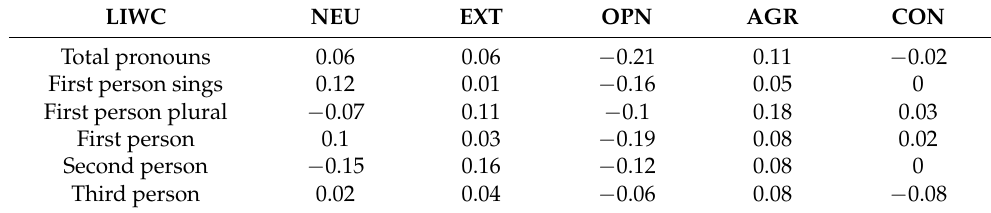
Figure 6. Analysis of relevant sentiments of predominant personalities: ( a ) negative sentiments of tweets by predominant personality; ( b ) the positive sentiment of tweets by predominant personal- ity.